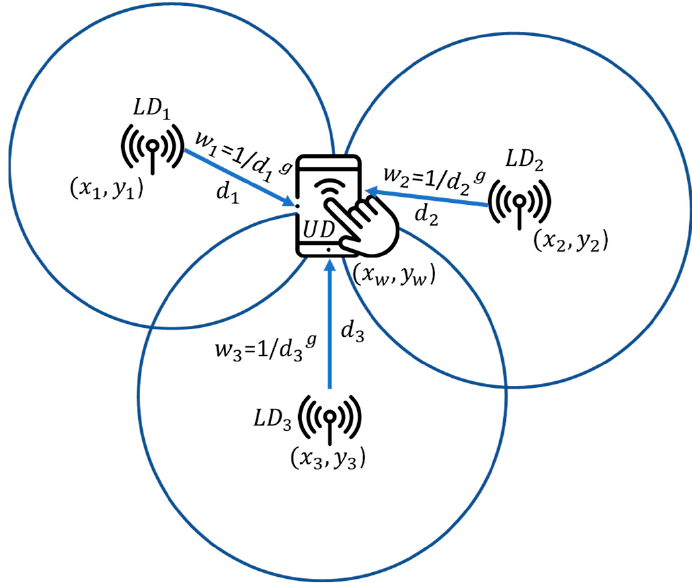
Figure 5. Illustration of the WCL method with three